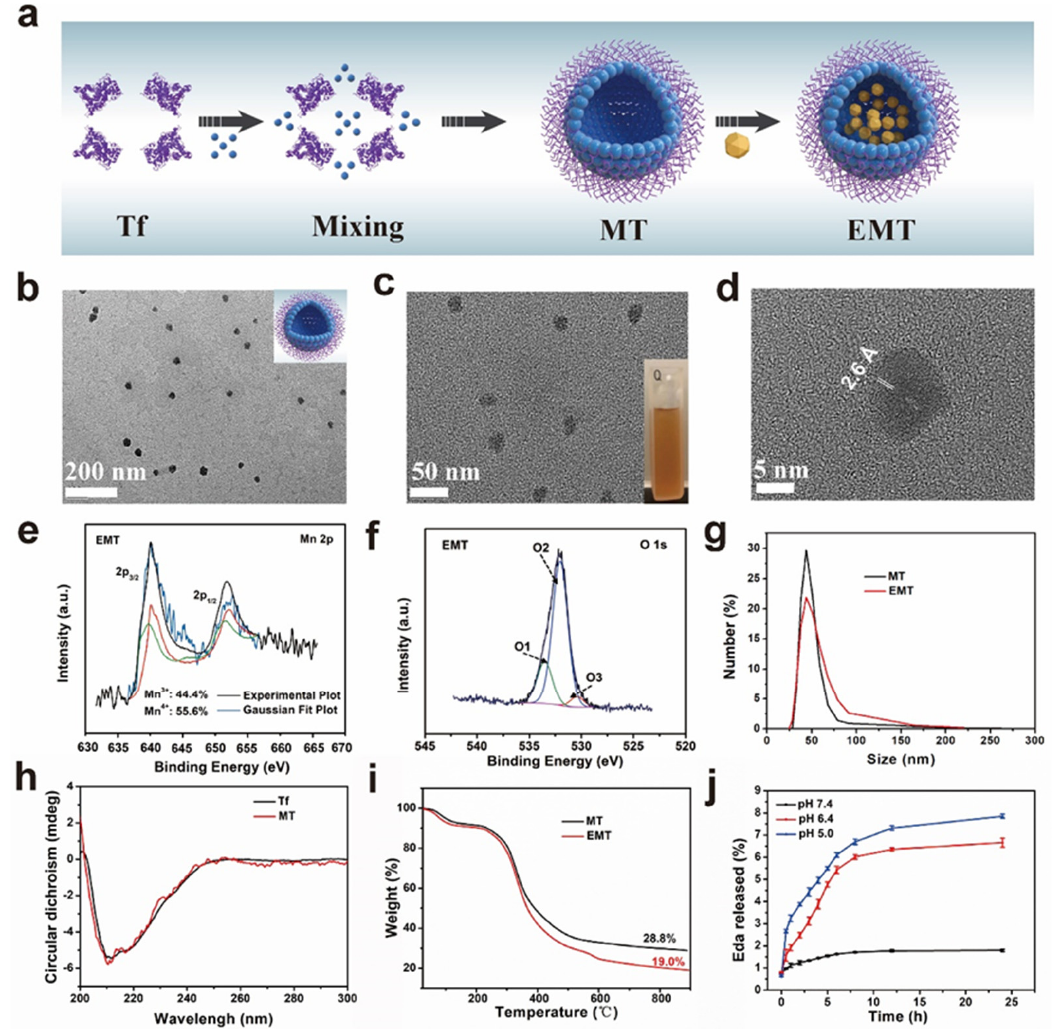
Figure 1. Synthesis process and characteristics of the EMT nanozyme. ( a ) Illustration diagram of the EMT nanozyme synthesis process. ( b – d ) Morphology of the EMT nanozyme at different scales (200 nm, 50 nm, and 5 nm), and right inset in ( c ) is a digital photo of the EMT nanozyme dispersed in water. ( e ) XPS analysis of the EMT nanozyme in the Mn 2p region (green line: Mn 3+ , red line: Mn 4+ ). ( f ) XPS analysis of the EMT nanozyme in the O 1s region (green line representing O1: adsorbed oxygen, blue line representing O2: oxygen defect, red line representing O3: lattice oxygen). ( g ) DLS results of MT and EMT. ( h ) CD spectra of Tf and MT. ( i ) Thermogravimetric analysis (TGA) of MT and EMT. ( j ) Eda release percentage at different pH values (5.0, 6.4, and 7.4).